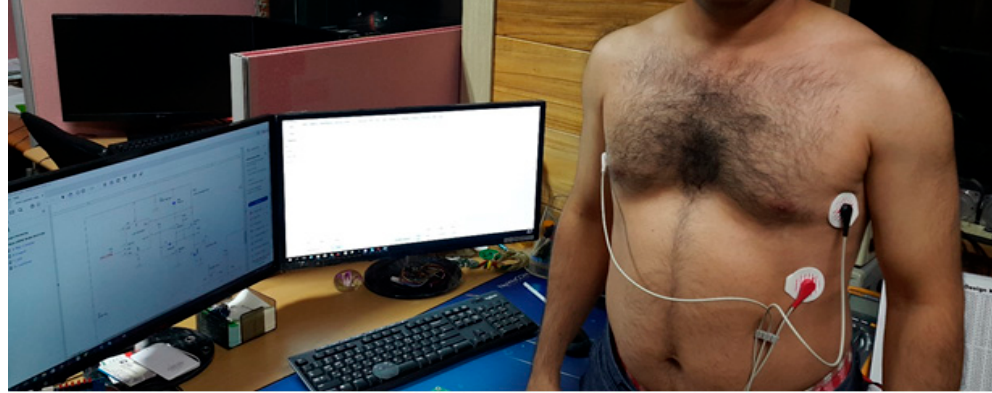
Figure 8. Experimental hardware set-up for wearable ECG signal collection.